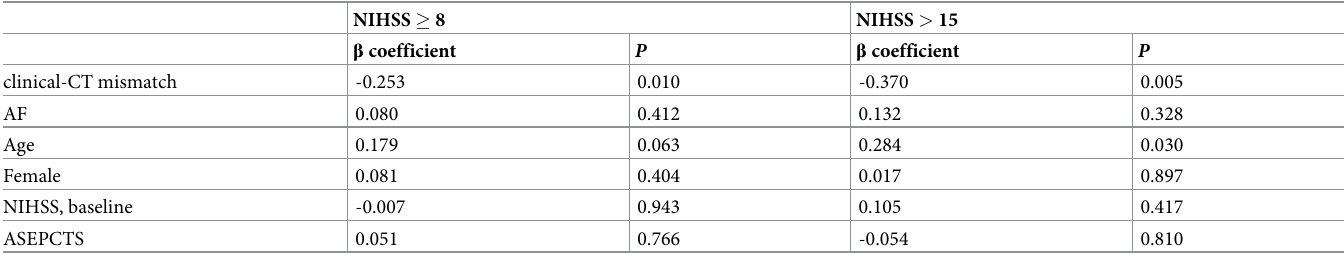
Table 5. Multivariate linear regression analysis: The effect of factors on delta NIHSS score (admission NIHSS—baseline NIHSS score).